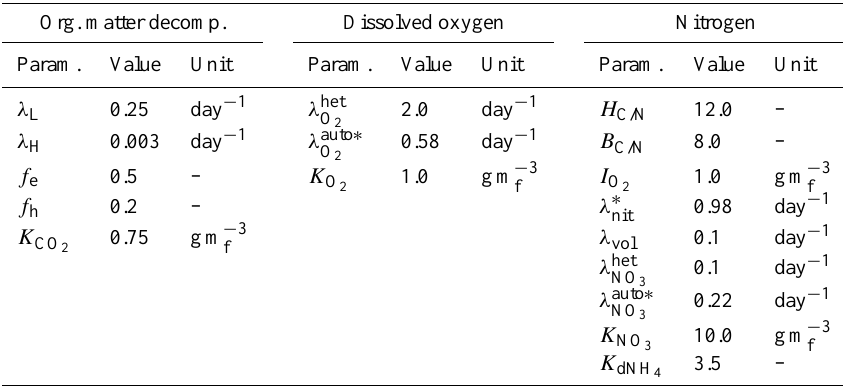
Table 2. Parameters and values for chemical reactions involving organic matter decomposition, dissolved oxygen, and nitrogen species for the baseline simulation model. Org. matter decomp. Dissolved oxygen Nitrogen Param. Value Unit